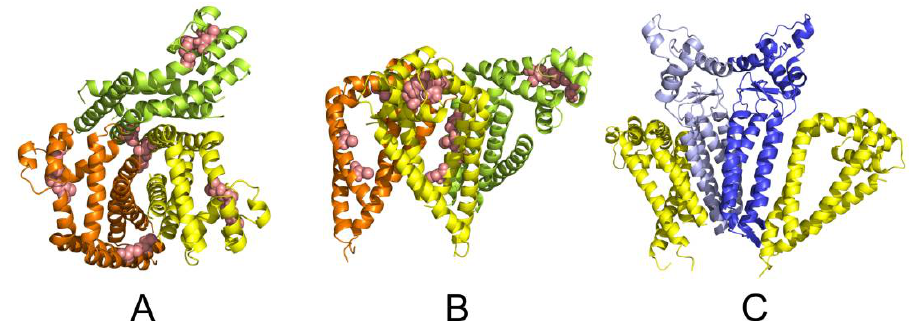
Figure 9. A summary of oligomer forming interfaces of CD81 and CD9. ( A , B ) Top and side view showing two possible binding modes of CD81 monomer (yellow) as predicted by flexible side-chain docking. The yellow-orange CD81 dimer displays a strong non-covalent interaction, while the less stable yellow-lime CD81 dimer can be further stabilized by formation of an intermolecular disulphide bridge. The Cys residues are shown in pink. A rotation of the covalently bound lime CD81 moiety could recruit another CD81 subunit leading to stepwise formation of CD81 oligomer stretch (see Figure 10); ( C ) The CD9 dimer (shades of blue) displaying two potential binding modes with CD81 moiety (yellow) as predicted by flexible side-chain docking.